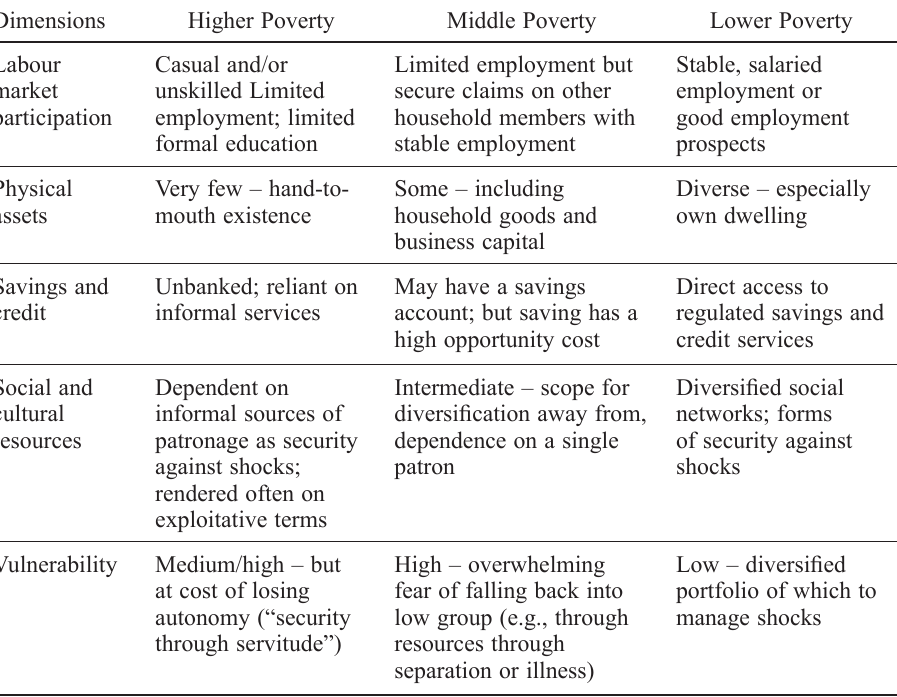
Table 2. Framework for classifying the poverty status of clients